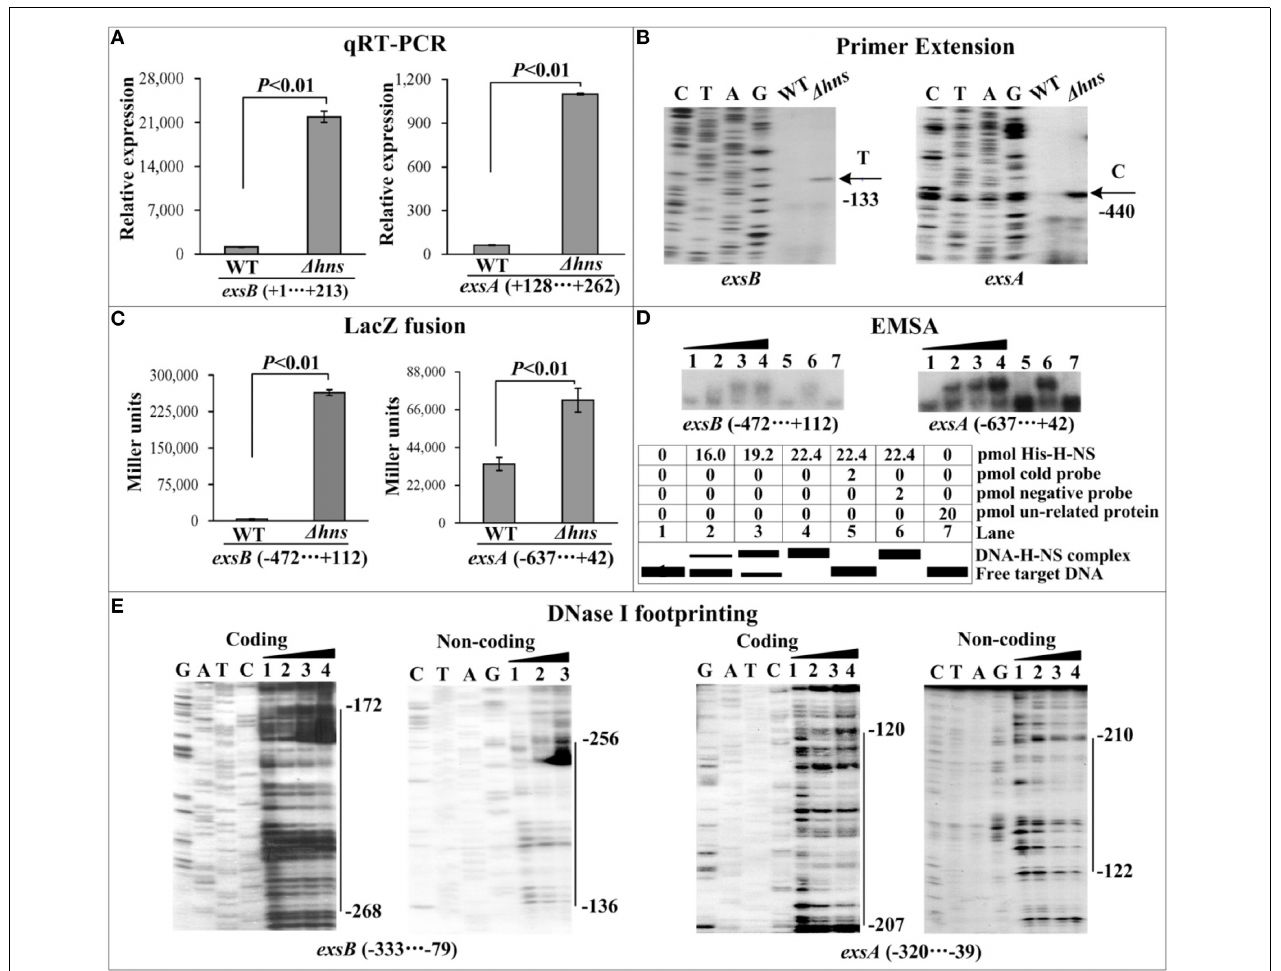
FIGURE 2 | Regulation ofT6SS1genes by H-NS. Lanes C,T,A,andG representtheSangersequencingreactions.Theminusandpositivenumbersin thebrackets orontheright sideof theverticalbarsindicatedthenucleotide positions upstream anddownstream ofindicatedgenes. (A) qRT-PCR. The relativemRNAlevels ofeachtarget genewere compared between (cid:2) hns and WT. (B) Primer extension. Anoligonucleotide primer wasdesigned tobe complementary totheRNAtranscriptofeachtarget gene. The primer extensionproductswereanalyzedwithan8Murea-6%acrylamidesequencing gel.Thetranscriptionalstartingsiteswereindicatedbyarrowswithnucleotides andpositions. (C) LacZfusion. Thetarget promoter-proximal DNAregion